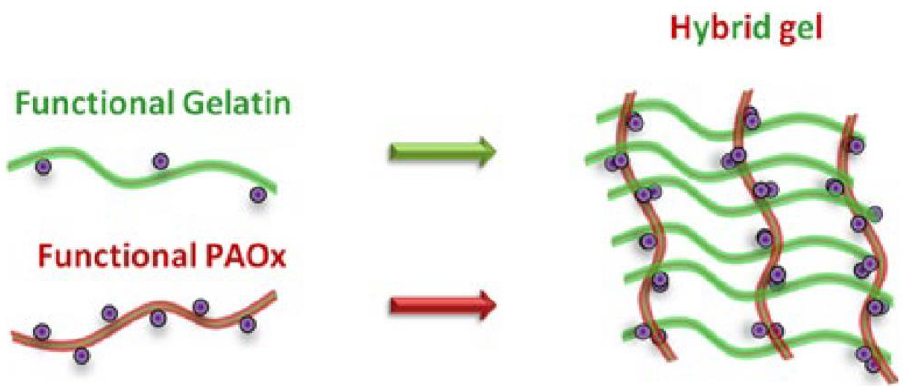
Figure 7. Schematic representation of the formation of a hybrid hydrogel [81].